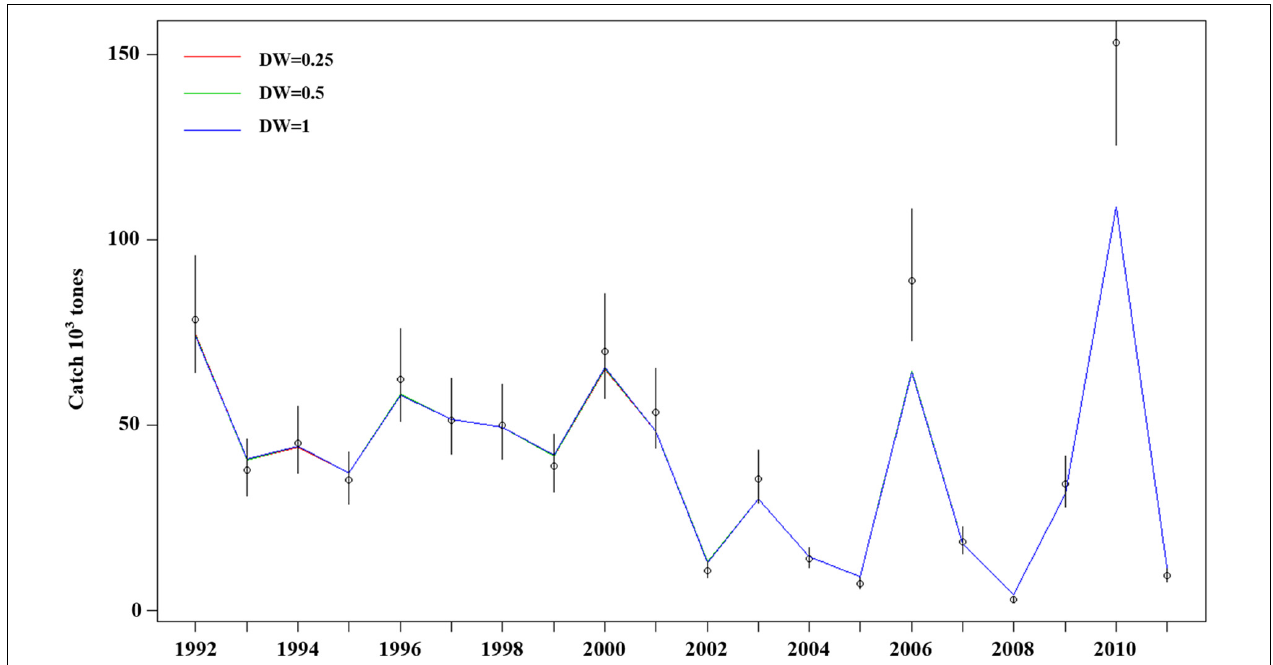
FIGURE 3 | Model fits (three solid line, red line present weights in 0.25, green line present weight in 0.5, blue line present weight in 1) to observed catch biomass (black dots) with the 95% confidence intervals (black line). The assumed CVs for the catch data are very small, so it is difficult to see the error bars and the fits to the data are quite